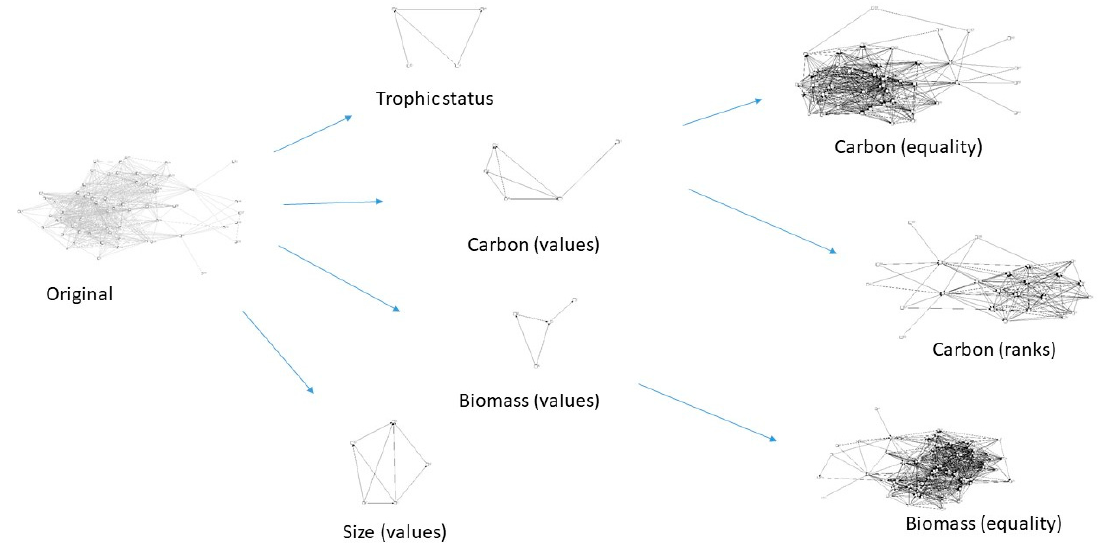
Figure 7. On the left, the original food web, shown in Figure 2. In the middle and on the right, its aggregated versions corresponding to 7 different ways of aggregation. Table 2. The identity of nodes in the not aggregated or only weakly aggregated trophic groups (A, B, C, D) according to 3 different trait-based aggregation procedures ( cv , bv , sv ; see explanation in the text).